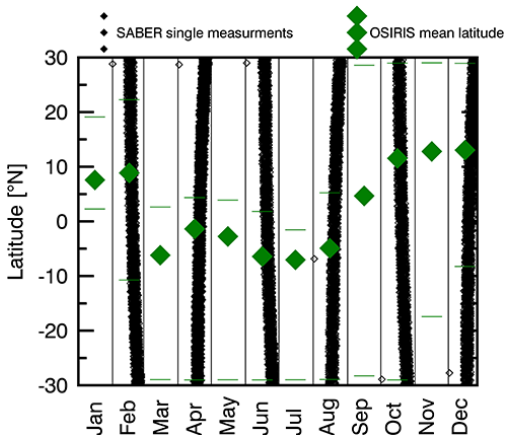
Figure 3. Collocation of the mean latitude of the OSIRIS monthly mean spectra (green diamonds) and the SABER measurements (black) that were made between 18:30 and 20:00 local time in the year 2008. The green horizontal lines indicate the maximum and minimum latitude of the OSIRIS